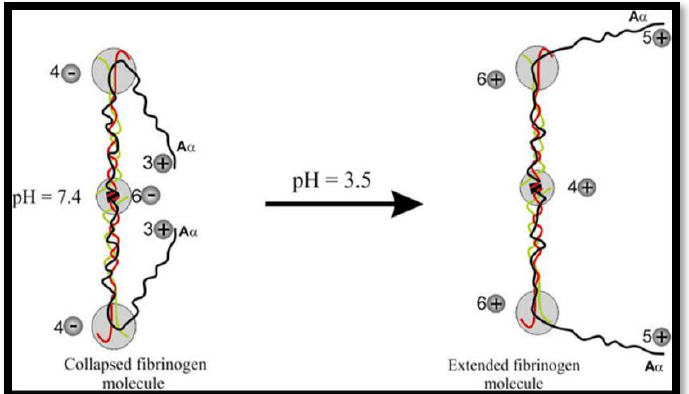
Figure 1. Effect of pH on fibrinogen charge distribution [36]. Table 1. HSA conformational transitions as the pH is varied